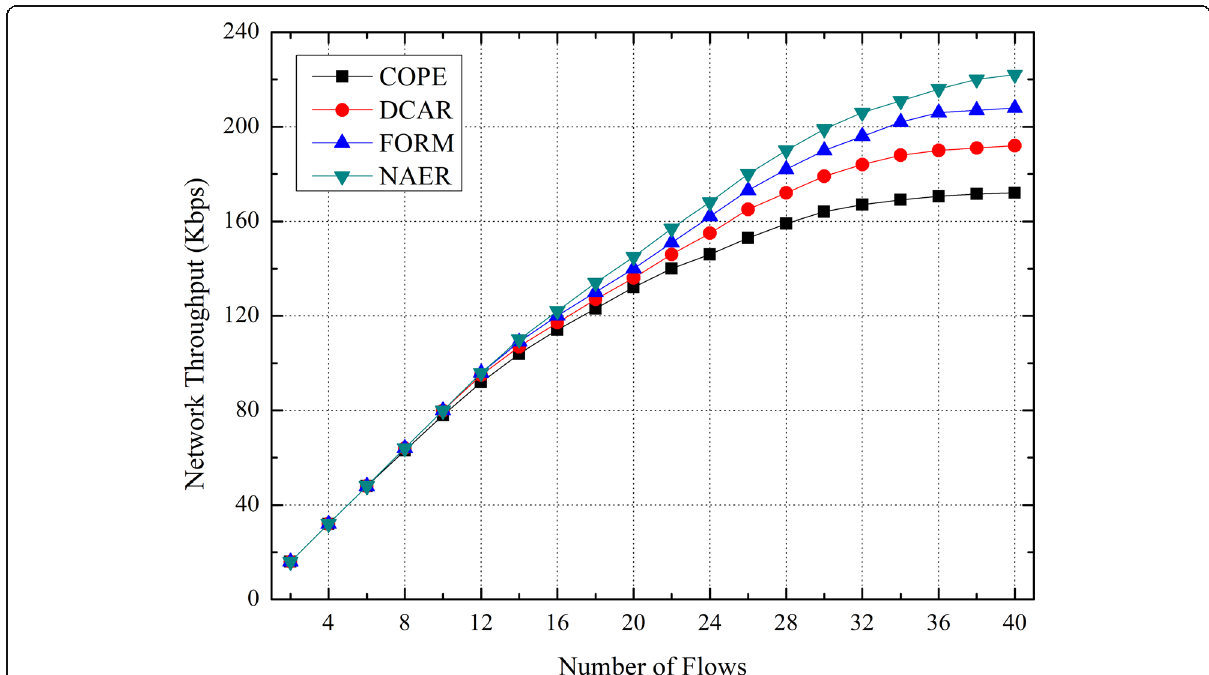
Fig. 19 Network throughput under different number of flows in grid network. Figure 19 shows the network throughput comparison of COPE, DCAR, FORM, and NAER under different number of flows in grid